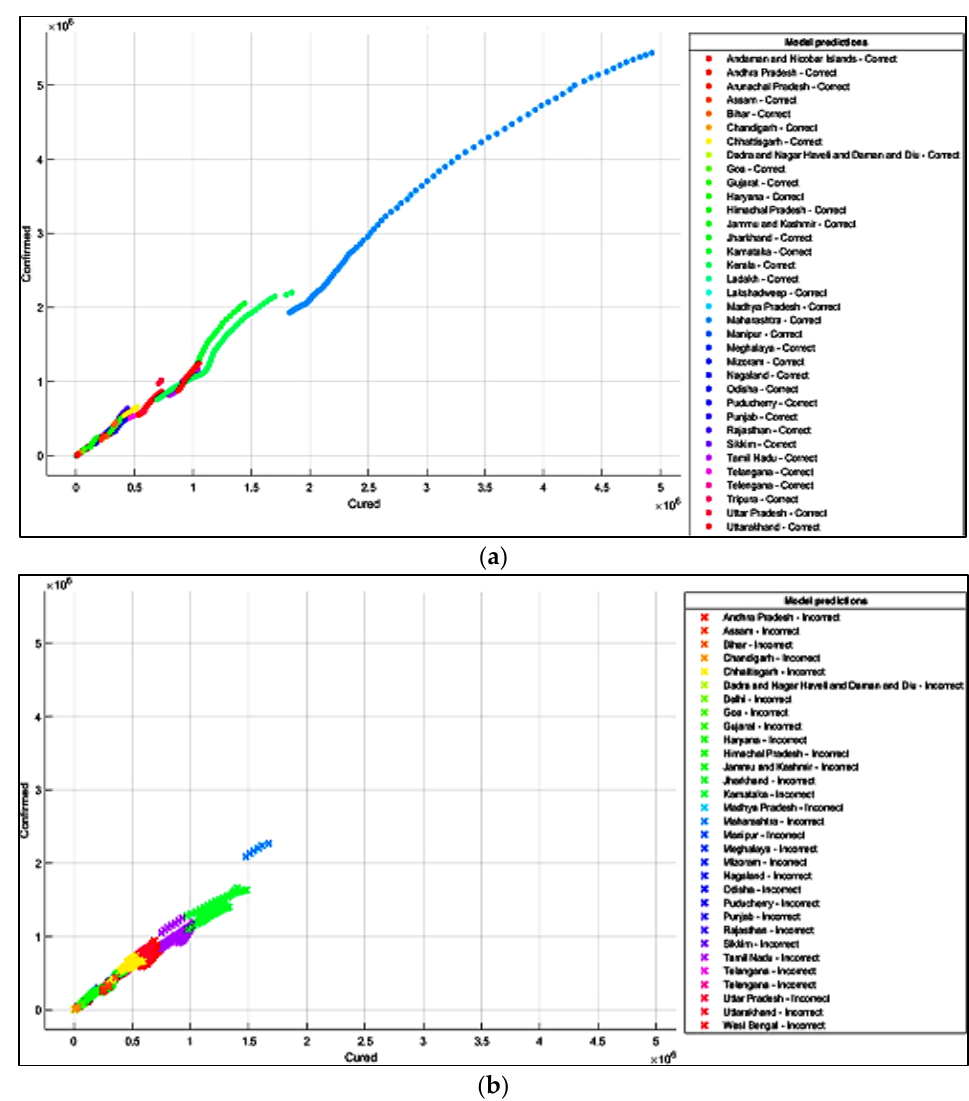
Figure 8. ( a ) Correct Predictions by Gaussian Naïve Model ‘Cured’ vs. ‘Confirmed’. ( b ) Incorrect Predictions by Gaussian Naïve Model ‘Cured’ vs. ‘Confirmed’.